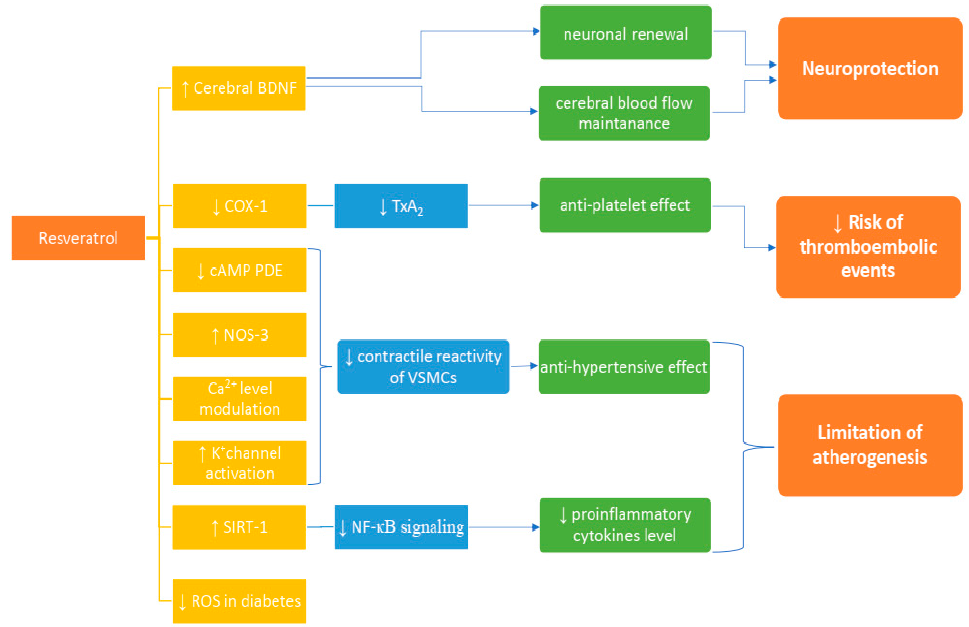
Figure 1. Proposed mechanisms of resveratrol activity . COX-1: cyclooxygenase type 1; cAMP: